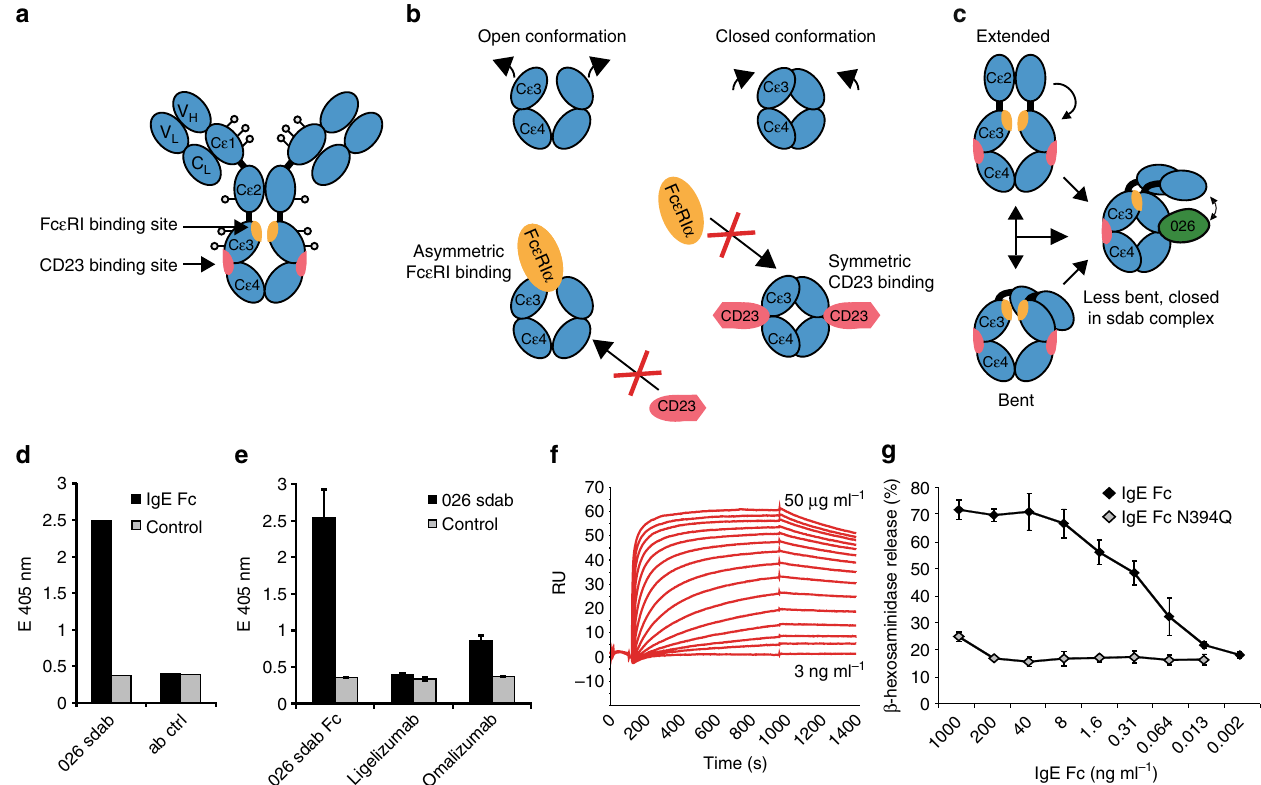
Fig. 1 Organization and conformational rearrangements of the IgE Fc. a IgE and the binding sites of the Fc ε RI (orange) and CD23 (pink) (adapted from ref. 23 ). The glycosylations are indicated by dots. b Representation of the open and closed conformations of the IgE Fc C ε 3 – 4 domains, and the mutual allosteric inhibition by Fc ε RI α (orange) and CD23 (pink). c Representation of the bent and extended conformation of IgE Fc C ε 2 – 4 and the conformation in the 026 sdab complex, together with the relative position of the C ε 2 domains. d Immunoreactivity of the 026 sdab to recombinant IgE Fc was assessed by ELISA. e Interference of the 026 sdab with different anti-IgE antibodies was assessed by sandwich ELISA using 026 sdab for capturing IgE Fc. Data are mean ± s.d. Detection of bound anti-IgE antibodies was performed using anti-IgG antibodies coupled to alkaline phosphatase. f The af fi nity of the 026 anti- IgE binding to immobilized IgE Fc was assessed by surface plasmon resonance. g Biological activity of recombinant IgE Fc and an IgE Fc lacking the glycan at N394 in mediator-release assays. Data are mean ± s.d. RBL-SX38 cells expressing the human Fc ε RI were sensitized with IgE Fc. Degranulation was induced by the addition of anti-IgE and monitored by released β -hexosaminidase